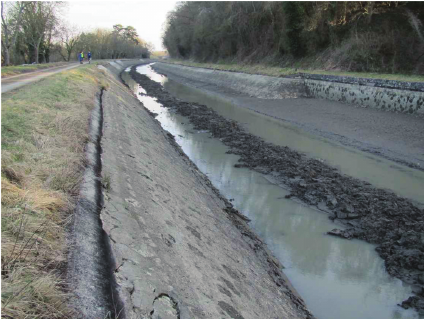
Figure 1: General view of the embankment.